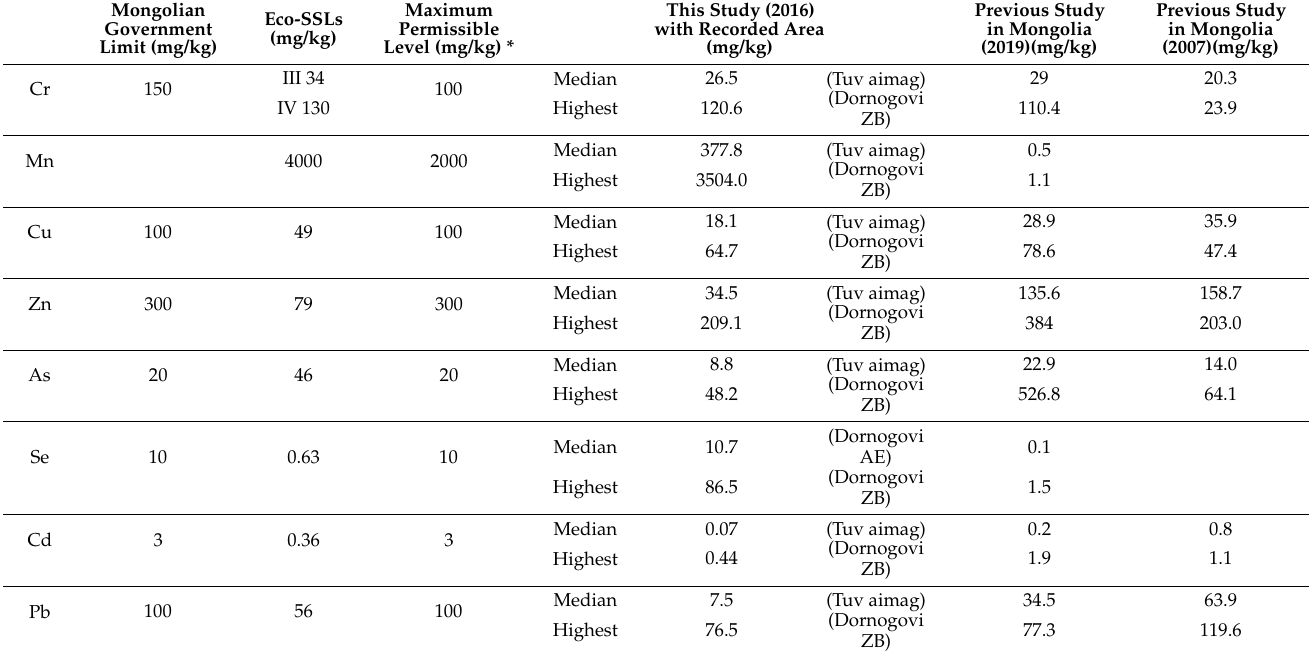
Table 1. Metal concentration in soil in this study, previous study in Mongolia, and maximum allowable limits.